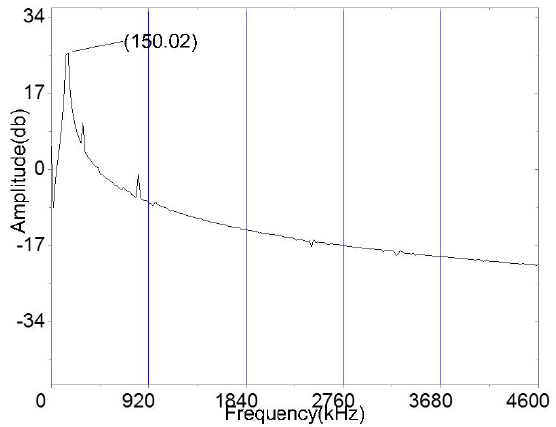
Figure 16. Amplitude-frequency curves.